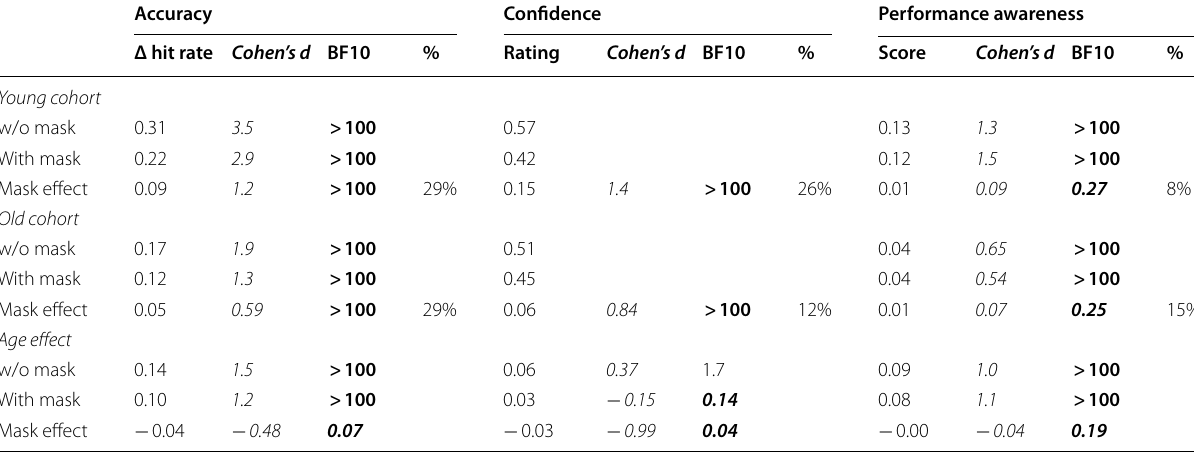
All comparisons are one-sided and signs indicate the direction of an effect relative to the prediction (see text). BF10 > 3 (at least moderate evidence for H1) are bold and BF10 < .33 (at least moderate evidence against H1) are bold and in italics. Δ hit, hit rate minus chance; %, relative decline due to face masks (relative to faces without masks). Confidence ratings are rescaled to unity (minimal possible value 0, maximal possible value